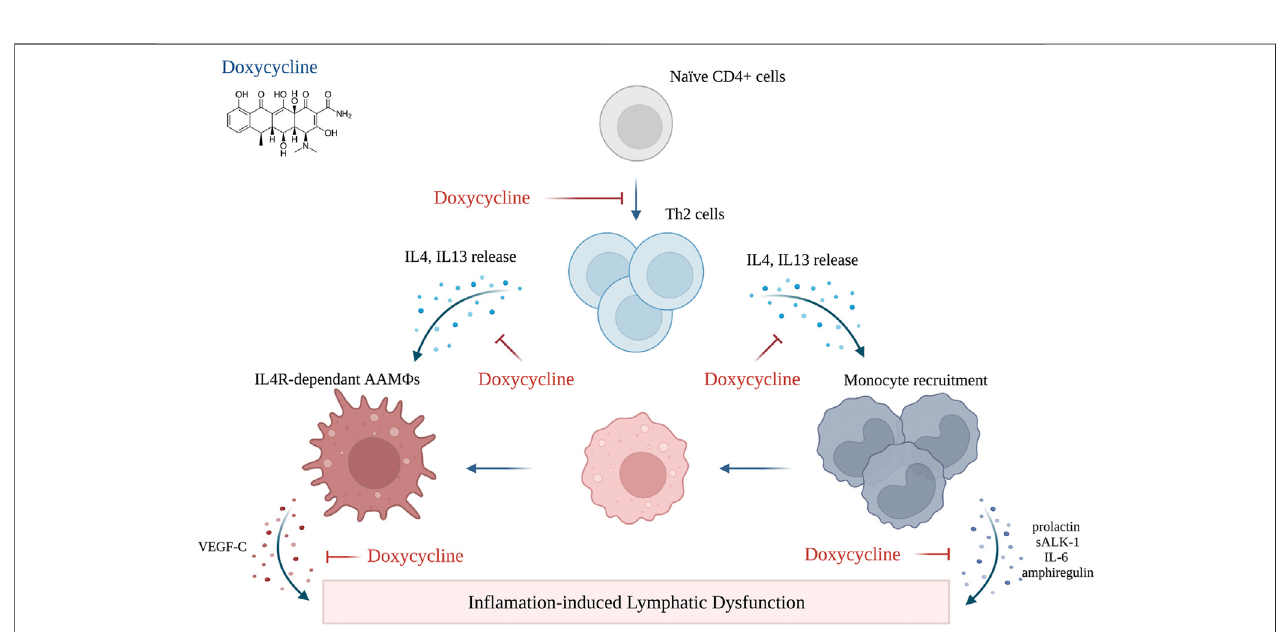
FIGURE 4 | Mechanism of action of doxycycline (created with BioRender). Adopted from: (Furlong-Silva et al., 2021).